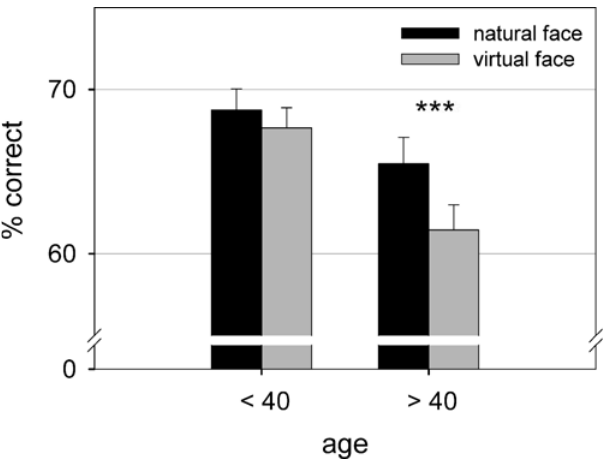
Figure 2. Recognition accuracy with standard error of mean for natural and virtual facial expressions in subjects under